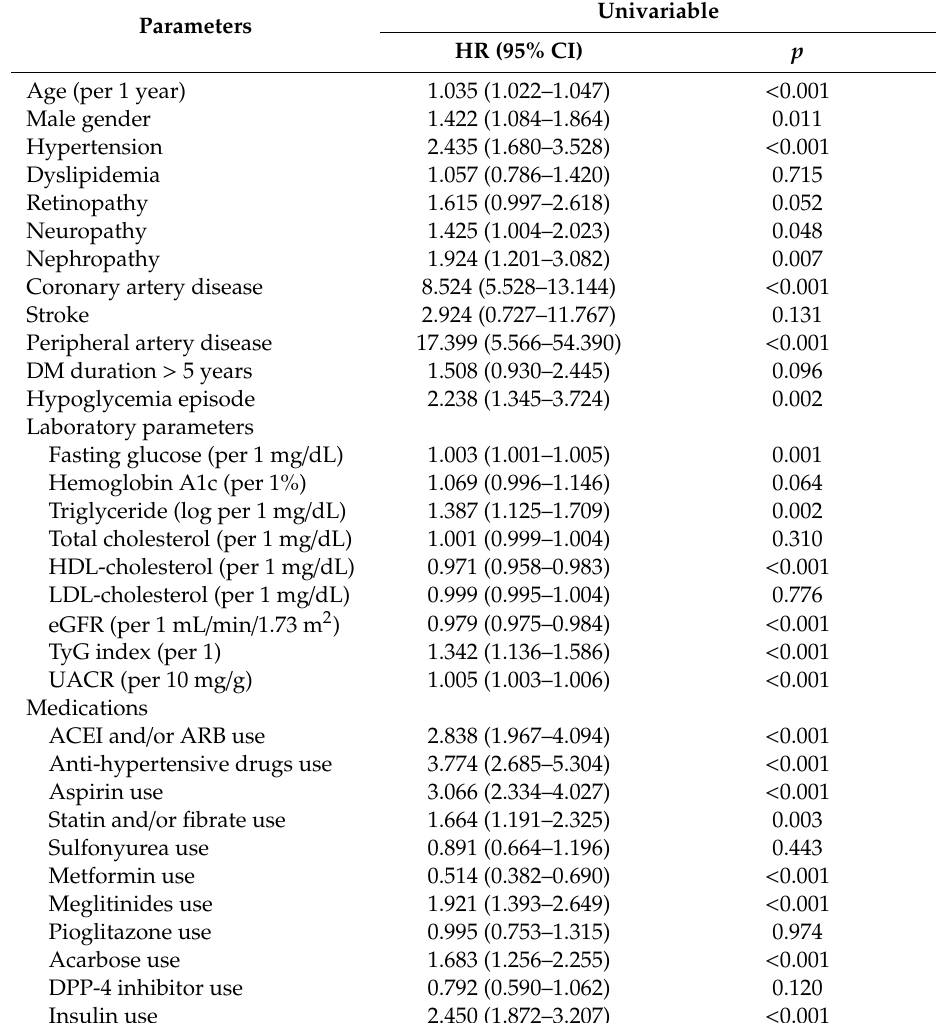
Table 2. Determinants for cardiovascular events using the Cox proportional hazards model (univariable